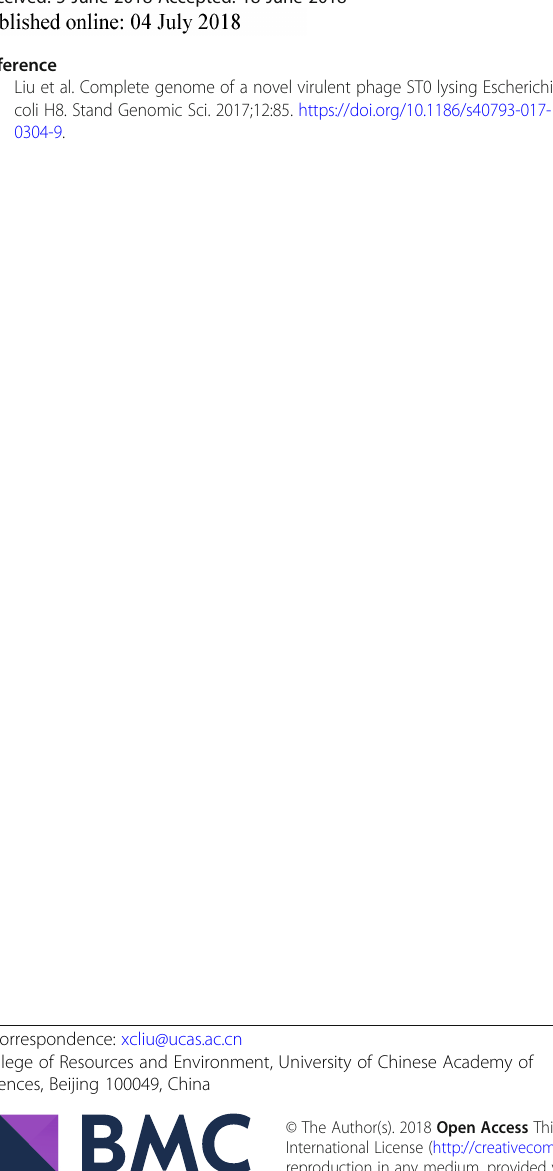
Table 1 of this original publication contained an error. The updated Table 1 is published in this correction article